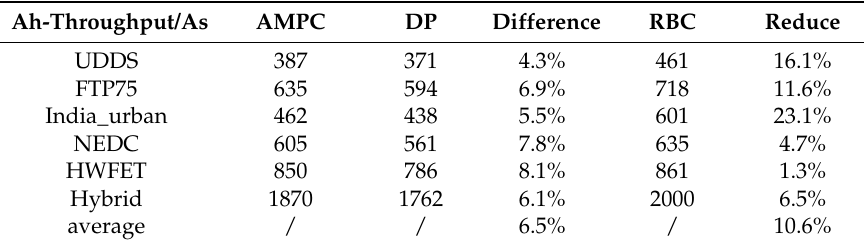
Table 6. LiB Ah-throughput of different EMSs.